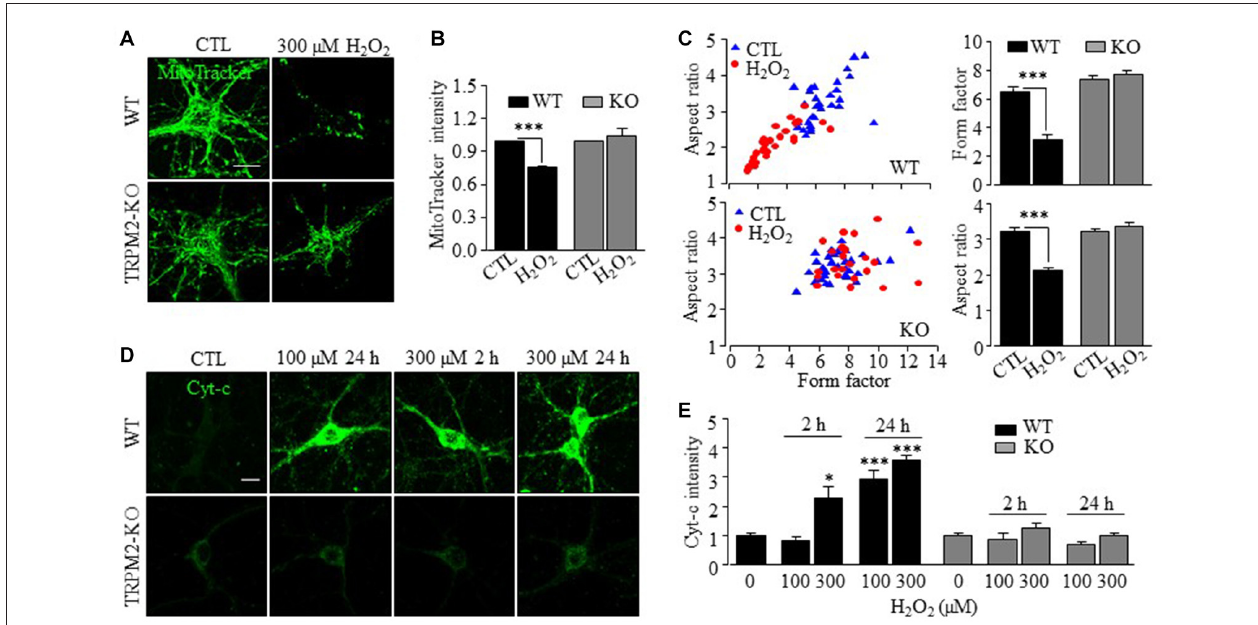
FIGURE 5 | TRPM2 channel has a critical role in H 2 O 2 -induced mitochondrial loss, mitochondrial fragmentation and cytochrome-c release in hippocampal neurons. (A) Representative confocal images showing MitoTracker Green fluorescence in WT (top two panels) or TRPM2-KO (bottom two panels) neurons under control (CTL) or treatment with 300 µ M H 2 O 2 for 30 min. (B) Mean MitoTracker Green fluorescent intensity in WT and TRPM2-KO neurons under indicated condition from 3 independent experiments with 10–12 neurons examined in each experiment. All values were normalized to control neurons in matched experiments. ∗∗∗ p < 0.005 indicates difference from control. (C) Computer-assisted analyses of mitochondria morphology. Left , distribution of the factor and aspect ratio values of mitochondria in neurons from 3 independent experiments with 10–12 neurons examined in each experiment. Blue triangles and red circles represent control neurons and neurons treated with 300 µ M H 2 O 2 for 30 min, respectively. Right , mean values of the form factor (top) and aspect ratio (bottom). ∗∗∗ p < 0.005 indicates difference from control. (D) Immunofluorescent images showing cytochrome-c (Cyt-c) staining in WT (top panels) and TRPM2-KO (bottom panels) neurons under indicated conditions. (E) Mean Cyt-c staining fluorescence intensity from three to four independent experiments with 15–25 neurons examined in each experiment. The values were presented relative to control neurons in matched experiments. ∗ p < 0.05 and ∗∗∗ p < 0.005 indicate difference from control. Scale bar is 10 µ m in (A,D)